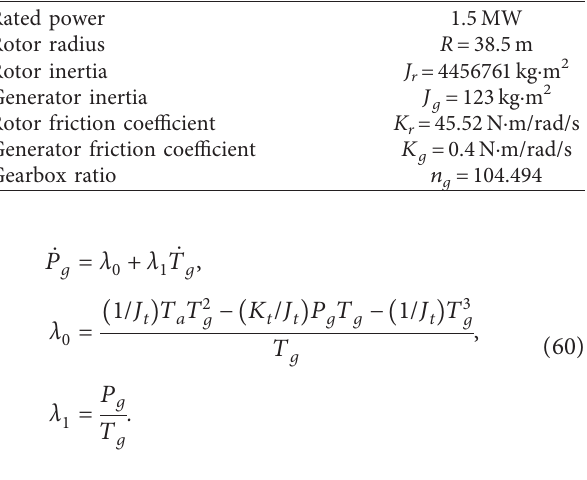
Table 1: Wind turbine